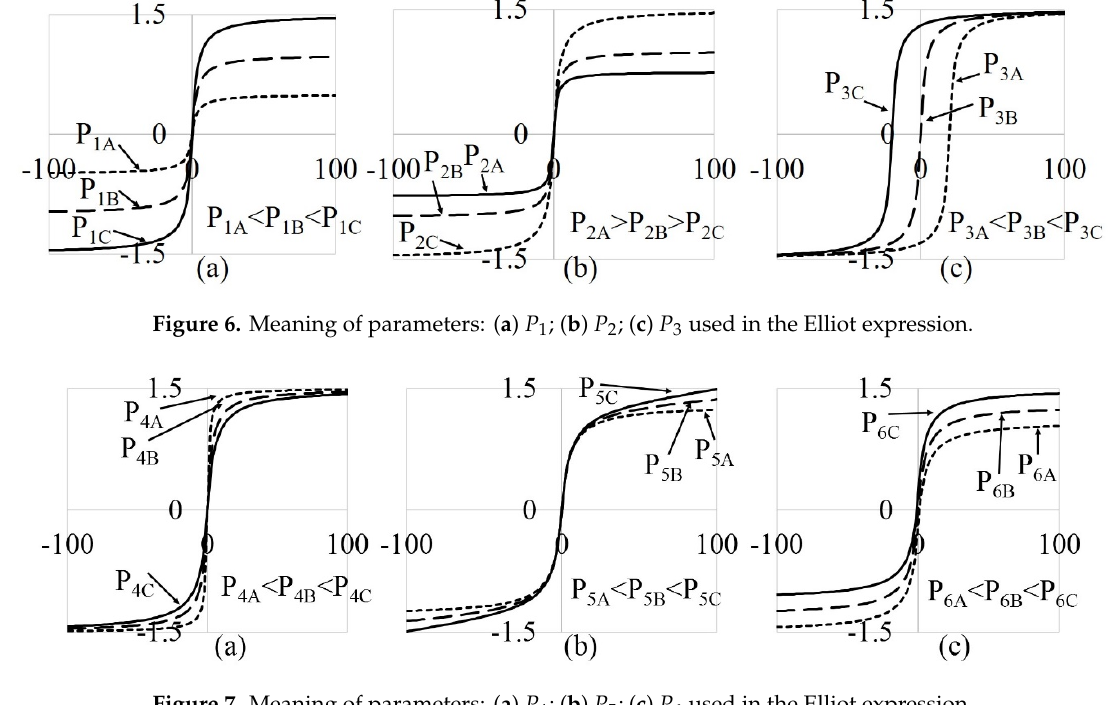
Table 9. Measured and calculated values of B at points A and K.